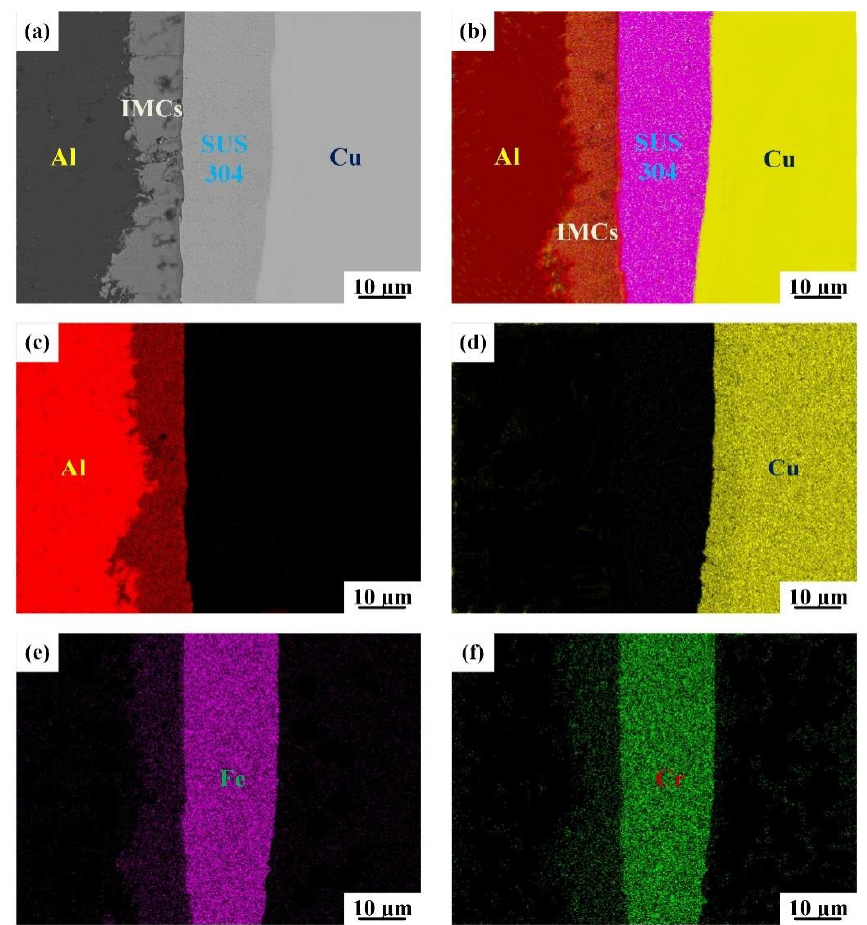
Figure 3. SEM images of the bonding interface for IFR-550 ( a ) and the corresponding EDS mapping: ( b ) EDS layered image, ( c ) Al element, ( d ) Cu element, ( e ) Fe element, ( f ) Cr element.